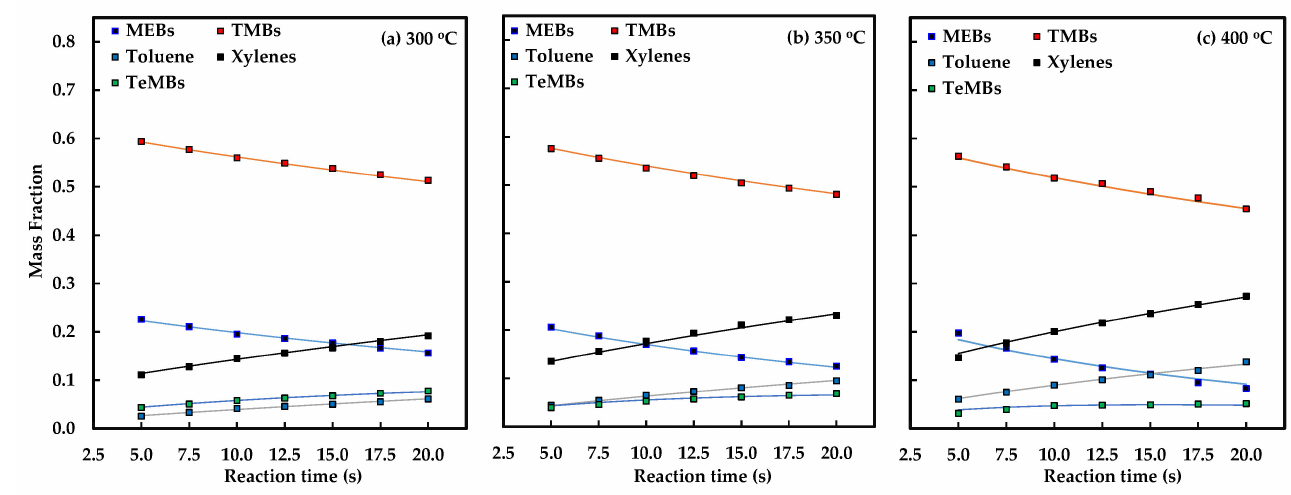
Figure 4. Products’ composition versus reaction time at different temperatures. [Experimental data (symbols) and model predicted values (solid lines)].